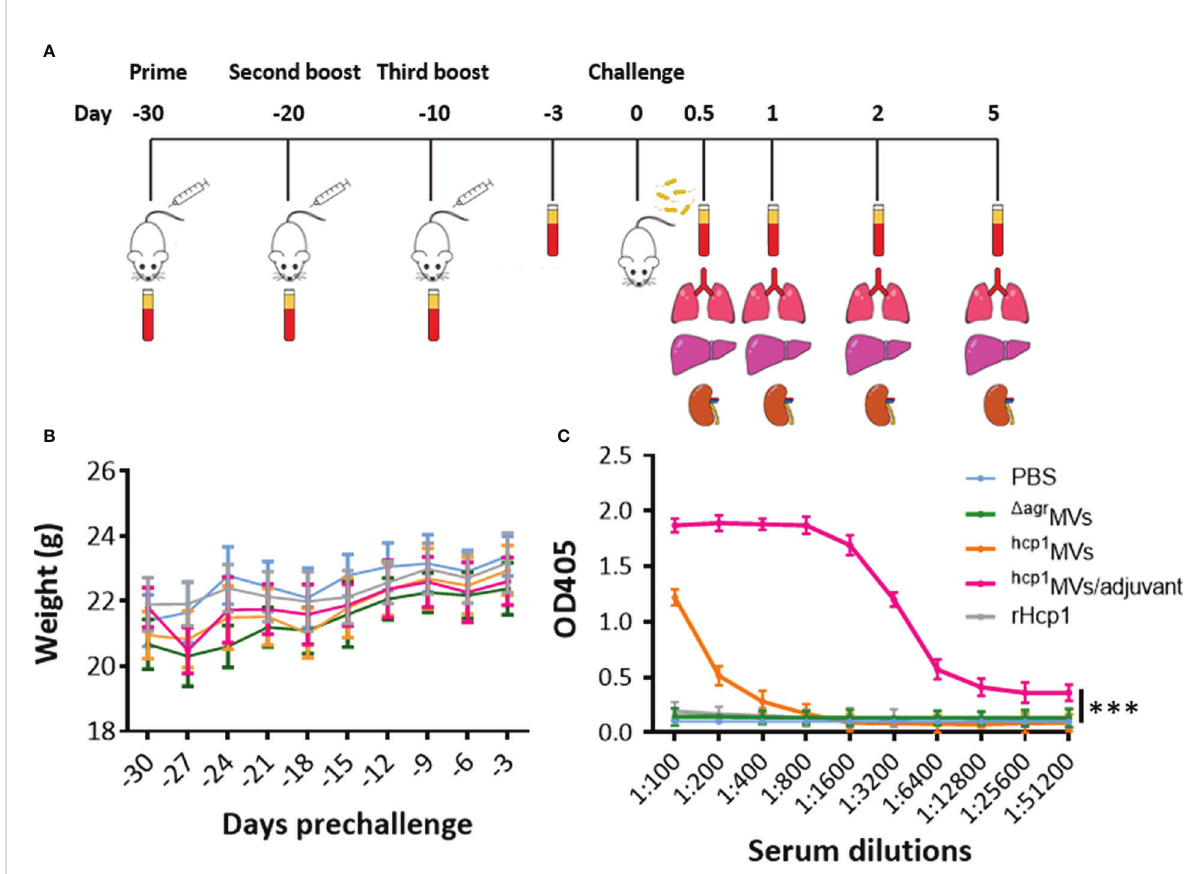
FIGURE 2 Body weight dynamics and serum antibody response of the vaccinated mice. (A) Experimental design and timeline of the regimen of PBS, D agr MVs, hcp1 MVs, hcp1 MVs/adjuvant, and rHcp1 vaccination, bacterial challenge, and sample collection. (B) Body weight dynamics of the vaccinated mice. Immunized BALB/c mice ( n = 10 per group) were weighed every three days, and the weight of all groups increased gradually during vaccination. (C) Quantitation of serum antibody titers raised against rHcp1. The serum IgG antibody titers of immunized mice ( n = 3 per group) on day -3 prechallenge were determined by ELISA and de fi ned as the highest serum dilution that exhibited an optical density (OD) value of 2.1 times relative to the negative control (PBS group serum). Statistical signi fi cance was calculated by two-way ANOVA, ***P <